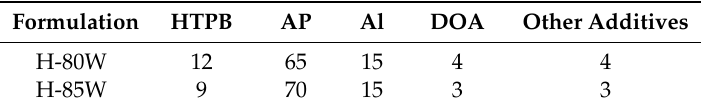
Table 1. Formulation of two Hydroxyl-terminated polybutadiene (HTPB) propellants with 80 wt.% and 85 wt.% filler density.